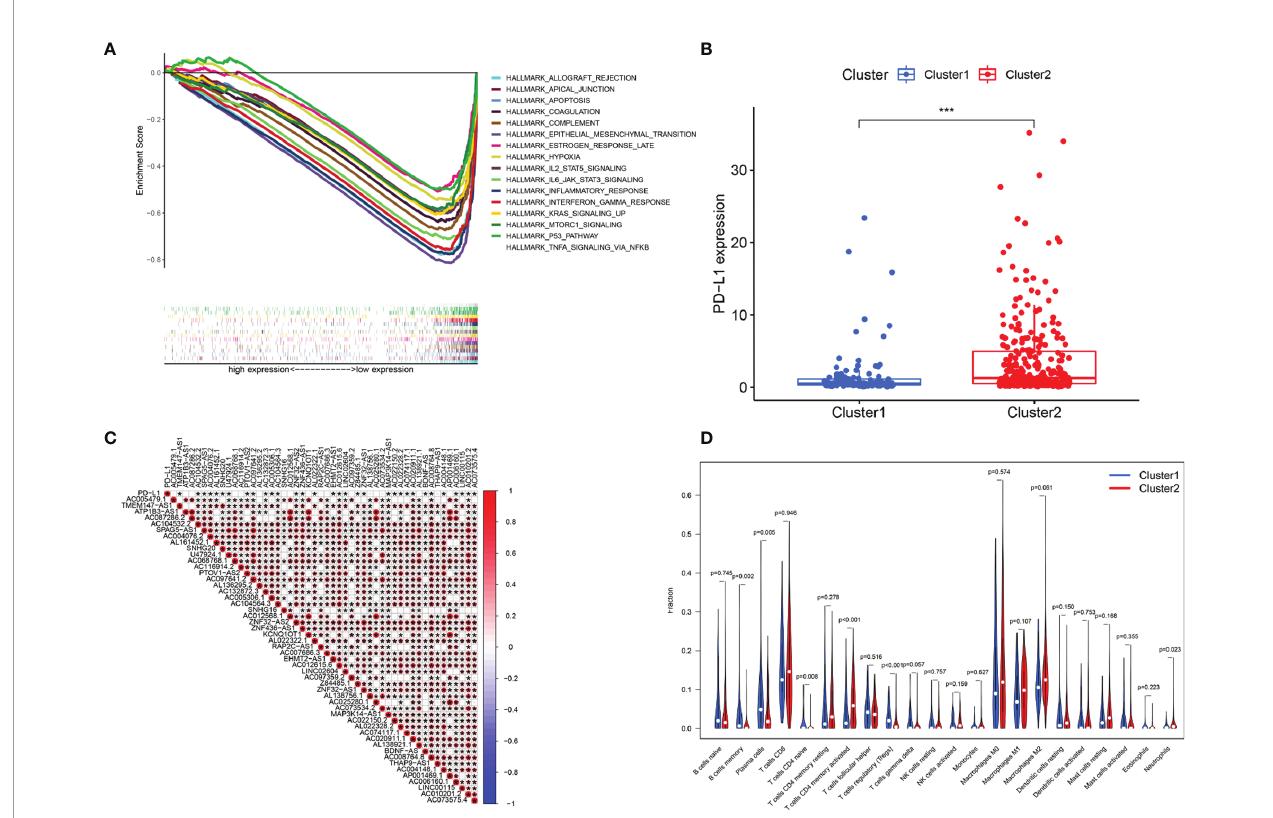
FIGURE 4 | Association of PD-L1 with m6A-related lncRNAs and the landscape of immune cell in fi ltration in BC cluster 1 and cluster 2. (A) GSEA indicating that tumor hallmarks were enriched in cluster 2. (B) PD-L1 expression in BC cluster 1 and cluster 2. (C) The correlation of PD-L1 with m6A-related lncRNAs. (D) The in fi ltration levels of 22 immune cell types in BC cluster 1 and cluster 2. * P < 0.05; *** P <